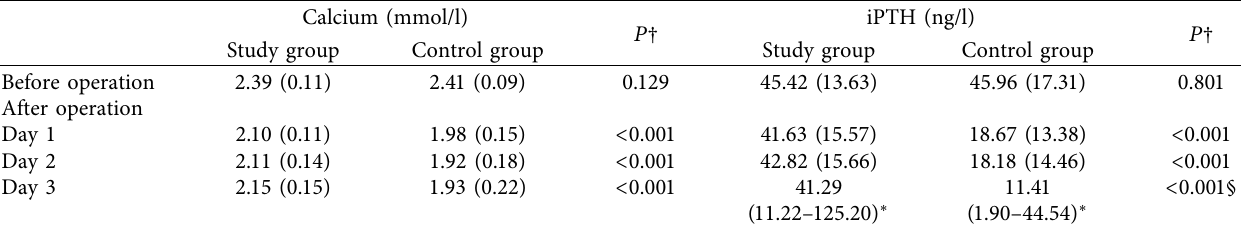
Table 4: Serum intact parathyroid hormone and calcium levels in patients who underwent total thyroidectomy and central neck dissection. Calcium (mmol/l) iPTH P †